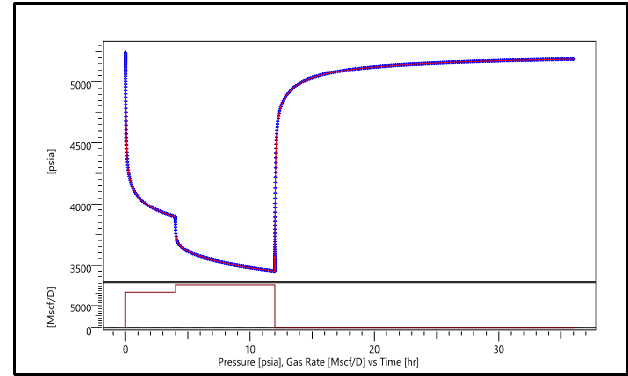
Fig.8. Plot representing Pressure, Production rate Vs Time